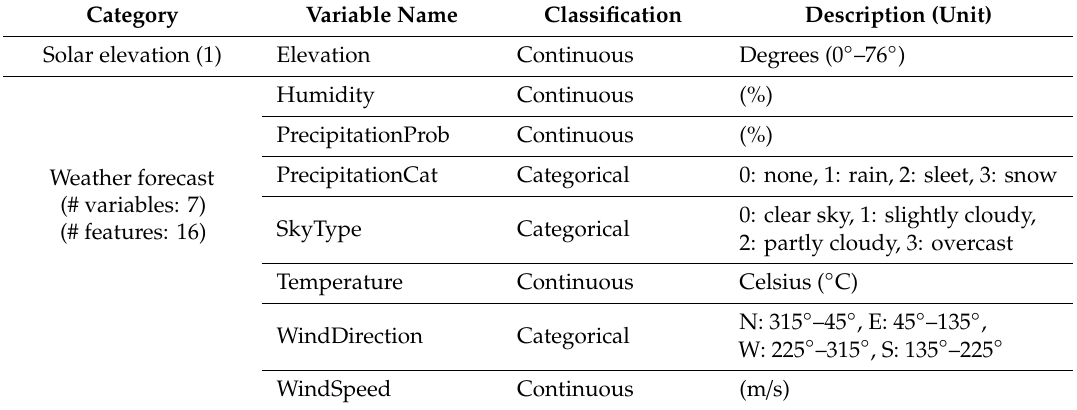
Table 1. Solar elevation and weather forecast variables.